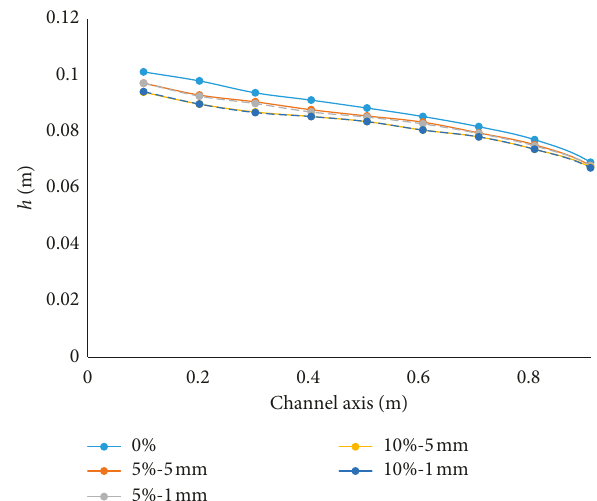
Figure 6: 3D CFD results of flow depth along the channel for different drill cuttings sizes and volume fraction at steady state. The inlet velocity is 0.5665m/s for all cases, and the total inlet volume flow rate value is equal for each case.